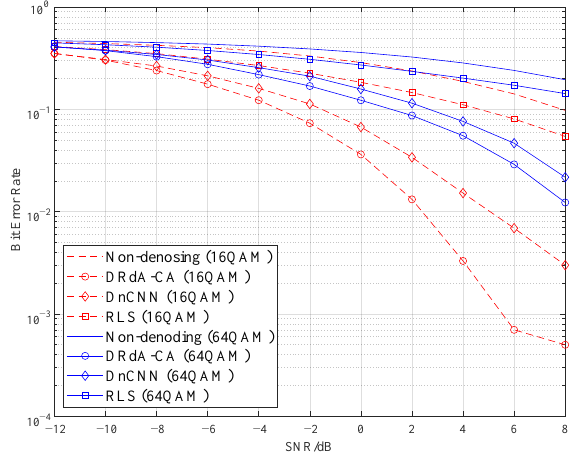
Figure 11. Demodulation BER after